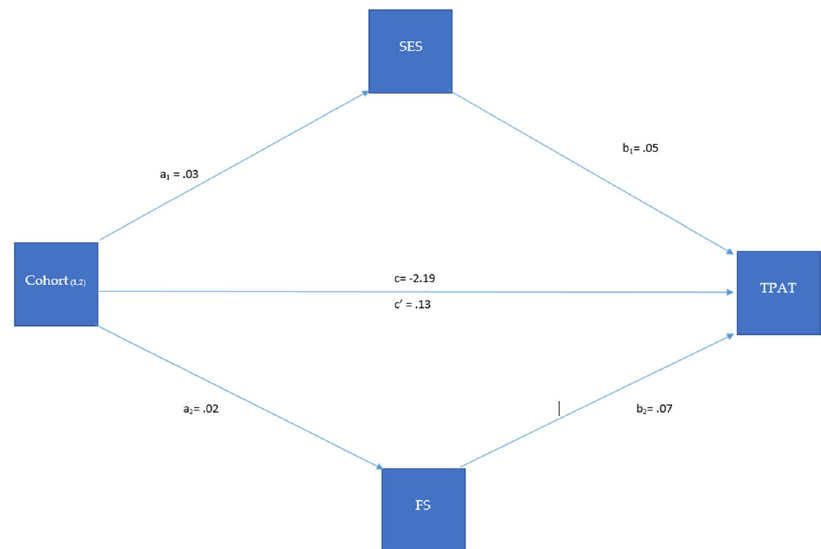
Fig. 1 Direct, Indirect, and Total Effects of Cohort (1,2) on